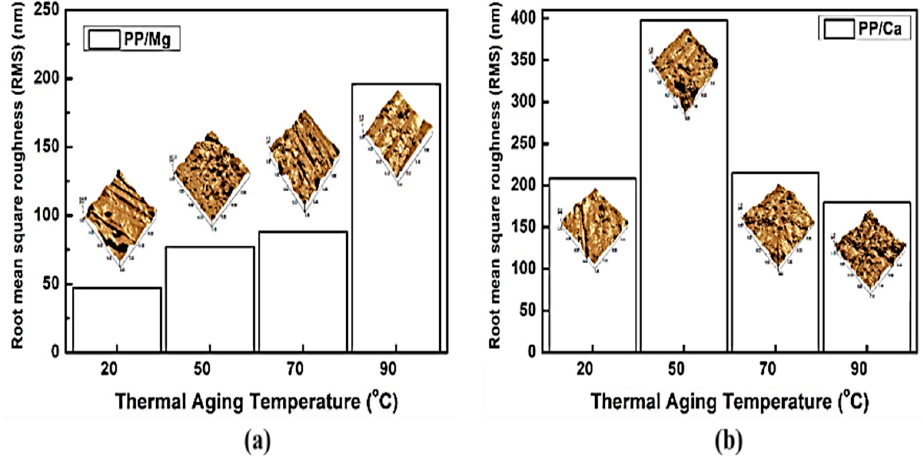
Figure 11. AFM images of polypropylene/lubricants composites thermally aged at different tem- peratures under 100% humidity: ( a ) PP/Mg; ( b ) PP/Ca.